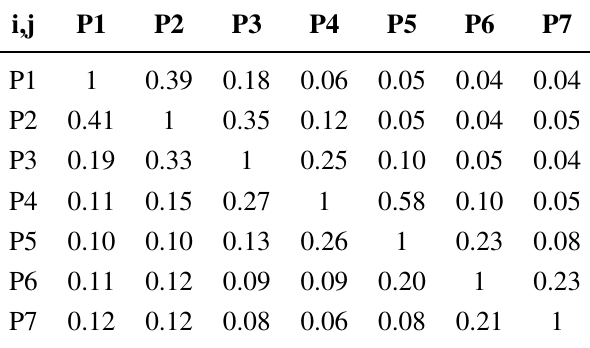
Table 4. Spectral interference coefficients of the filter bands. The data used is from the practical spectral characteristics of the filters from Figure